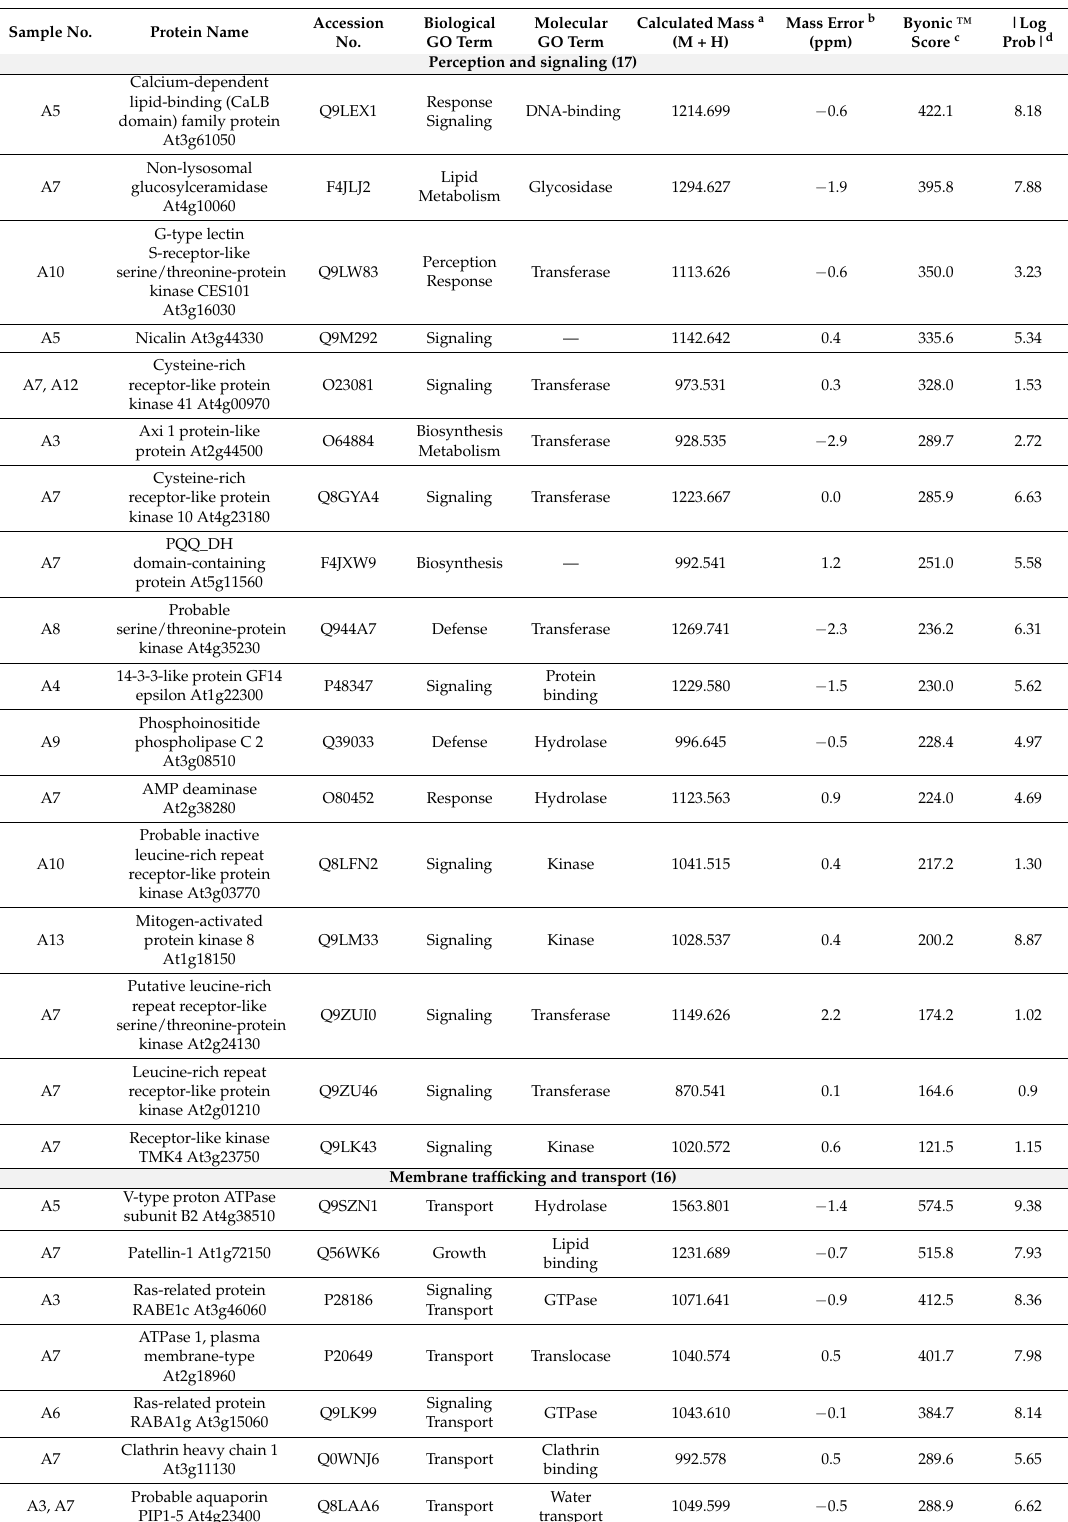
Table 1. LC-MS/MS identification of A. thaliana PM-associated responsive proteins from selected 1D SDS-PAGE bands of control, 0-, 6-, 12-, and 24 h fractions subsequent to ergosterol treatment and organized according to functional categories (Supplementary Data Sheet 1). Sample